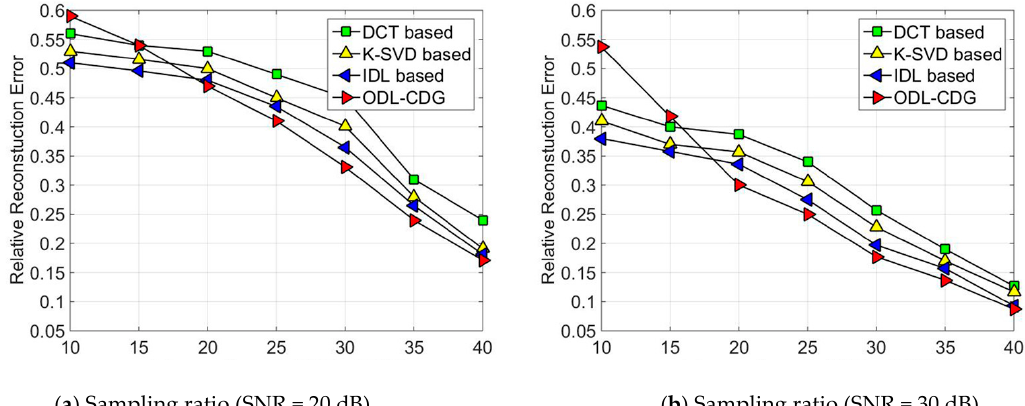
Figure 1. The relative reconstruction error of DCT, K-SVD, IDL and ODL-CDG under different signal-to-noise ratio: ( a ) Sampling Ratio = 10%; ( b ) Sampling Ratio = 20%; ( c ) Sampling Ratio = 30%; ( d ) Sampling Ratio = 40%.